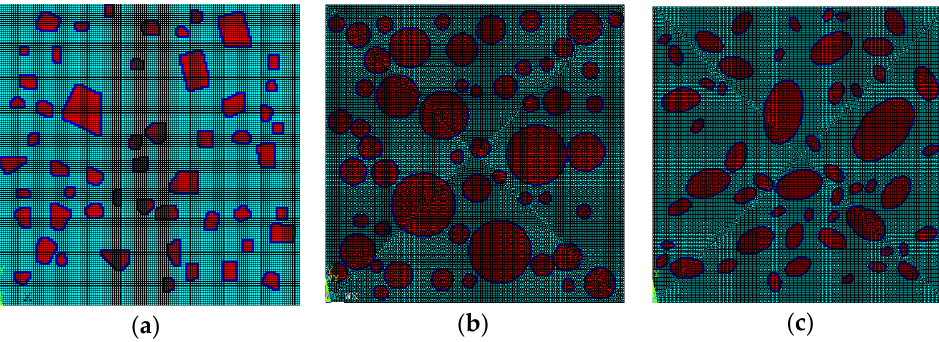
Figure 2. Finite element mesh diagram for 2D random aggregate models, ( a ) Polygonal aggregate, ( b ) Circular aggregate, ( c ) Elliptical aggregate.